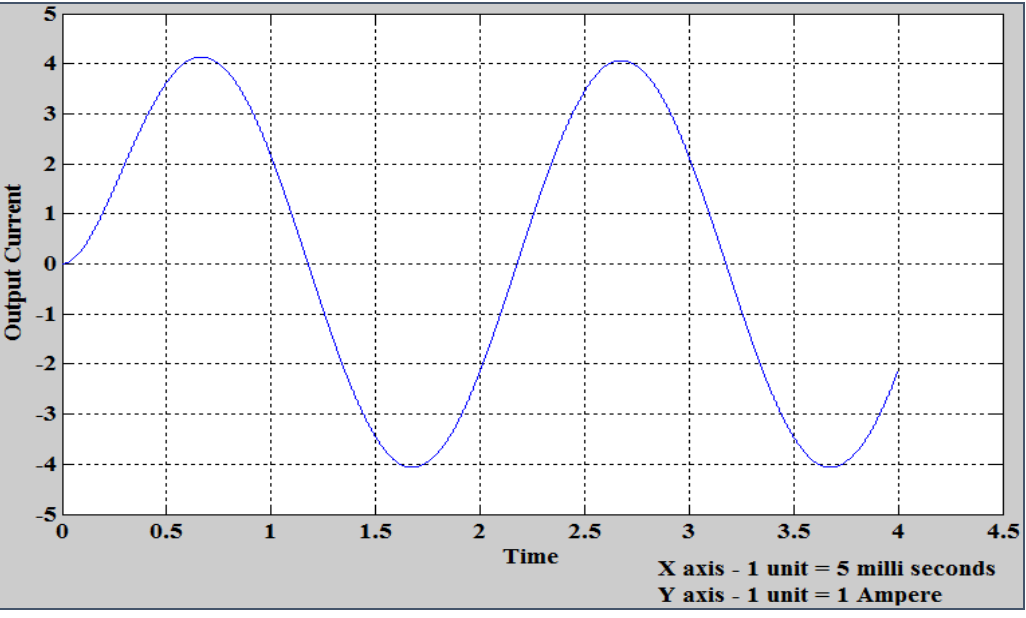
Figure 20. Output current vs. Time—RL load (50 + j31.4) ohm—Simulation.